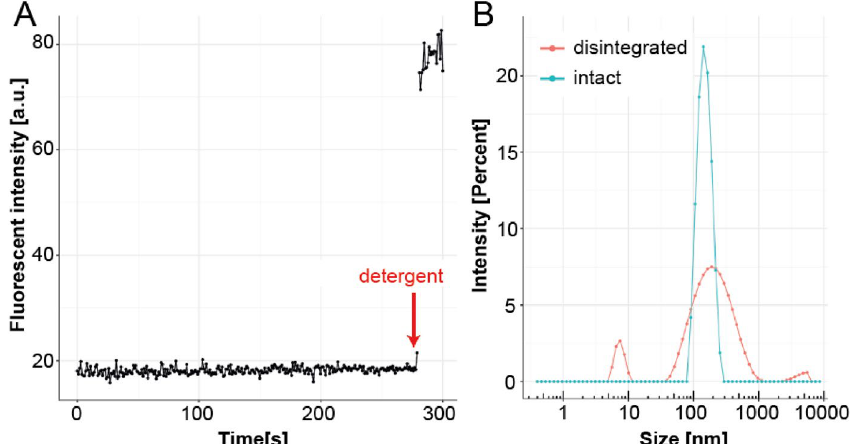
Figure 2. Effect of OEG on InViS. ( A ) The fluorescence intensity of InVis was monitored continuously over 300 s. After 280 s, OEG was added to the sample to induce viral disintegration and the release of the fluorescent R18 label from the viral membrane. ( B ) Particle size distribution measured by DLS before and after detergent administration. The intact InViS is highly monodisperse. When in contact with detergent, the virus disintegrates, leading to several populations of residual aggregates and a higher polydispersity index.